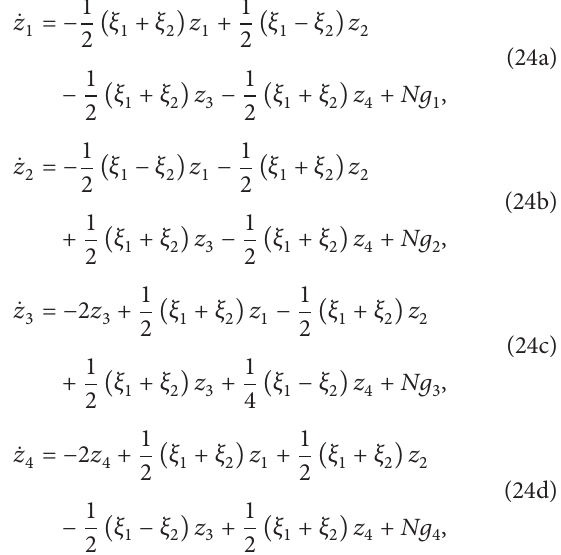
−1 , 𝜇 = −1 , 𝜎 = 1 , 𝜎 2 1 = 𝑎 = 𝑎 = 𝑎 = 𝑎 𝑎 4 5 6 7 = 𝑏 = 1 𝑏 10 11